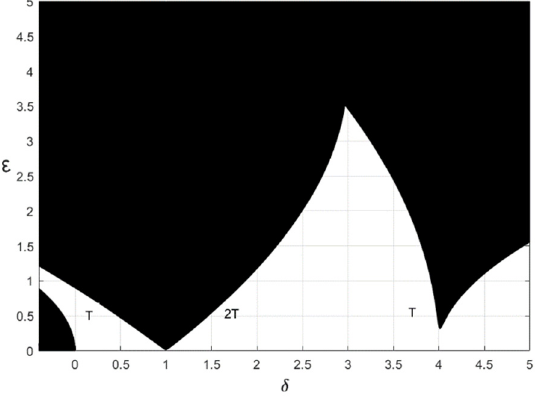
.. x + ( δ + 2 ε cos ( 2 t )) x =